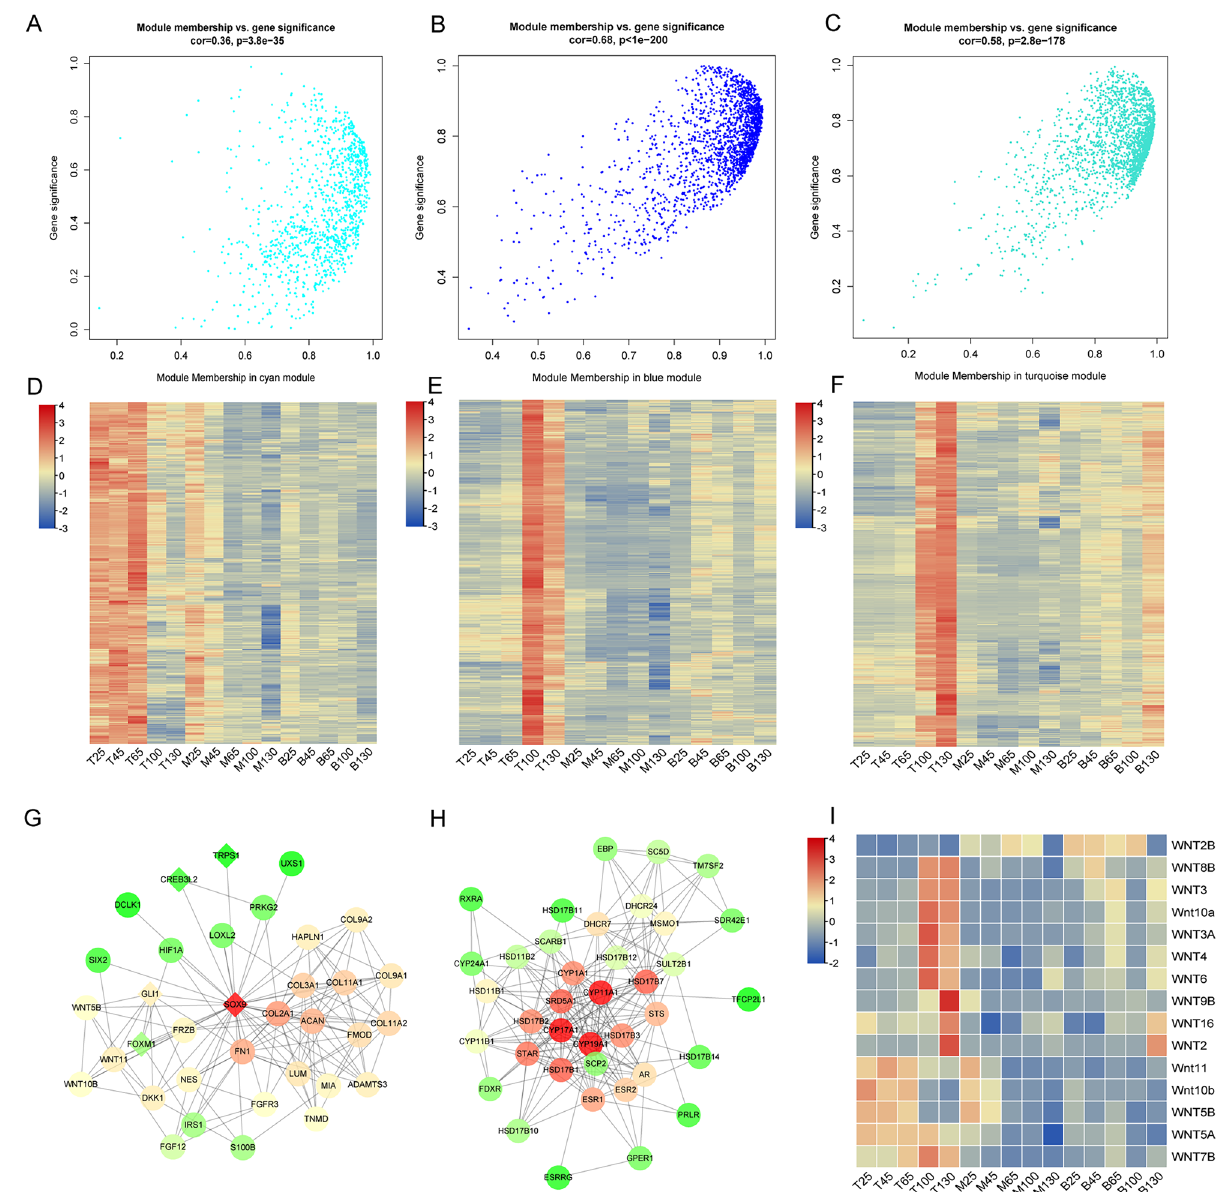
Figure 4. Rapid growth and ossification-related genes and networks. ( A , B , and C ) Scatter diagram of module membership and gene significance for cyan, blue and turquoise module were obtained by R WGCNA package (https:// cran.r- proje ct. org/ packa ge= WGCNA); ( D , E , and F ) Expression heat maps of genes in cyan, blue and turquoise modules were generated using Tbtools software (version 1.082, https:// github. com/ CJ- Chen/ TBtoo ls); ( G and E ) Networks of genes associated with rapid growth and ossification were established by the STRING database (version 11.5, https:// cn. string- db. org/) and visualized in the Cytoscape software (version 3.4.0, http:// www. cytos cape. org/); ( I ) Heat map of 15 WNT gene expression in different antler samples were generated using Tbtools